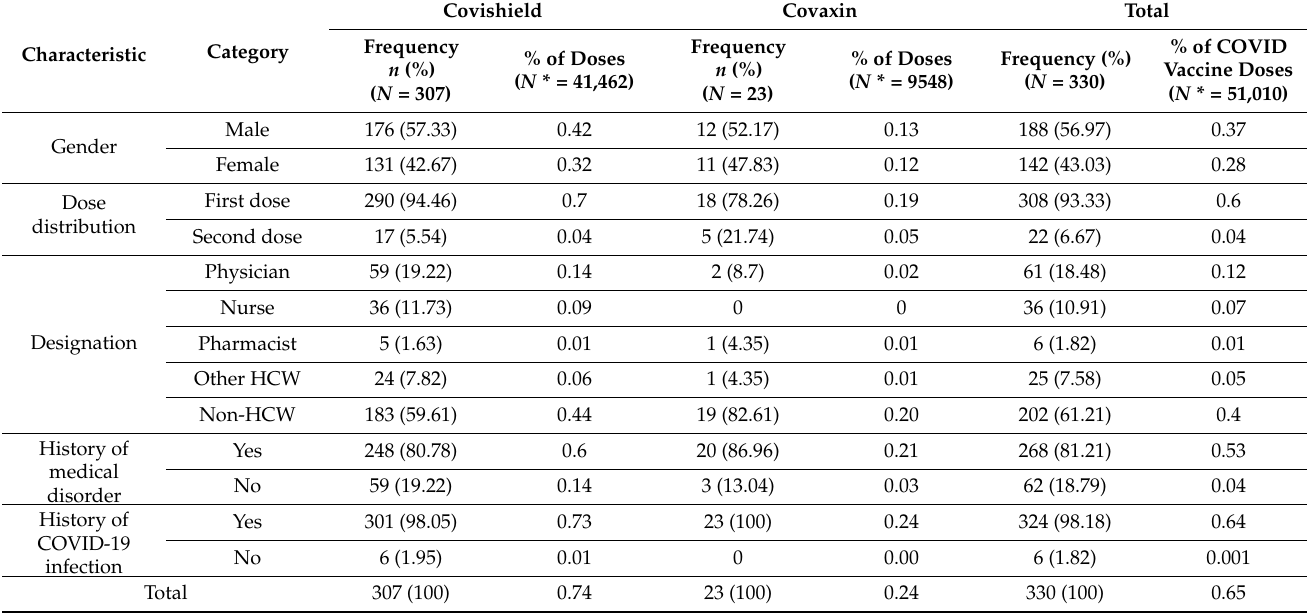
Table 1. Baseline characteristics and co-morbidity status of cases reporting AEFI.